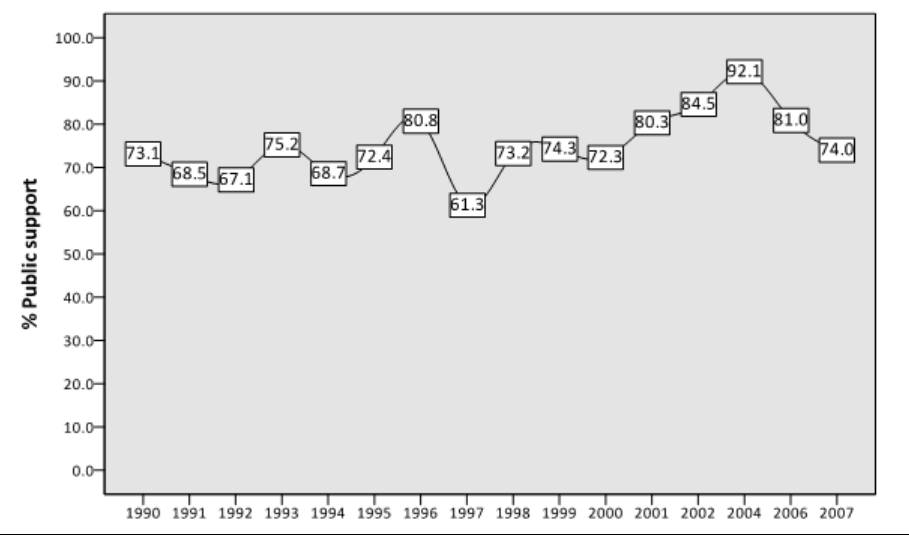
Figure 1. Average levels of public support for development aid/concern for poor in OECD countries,